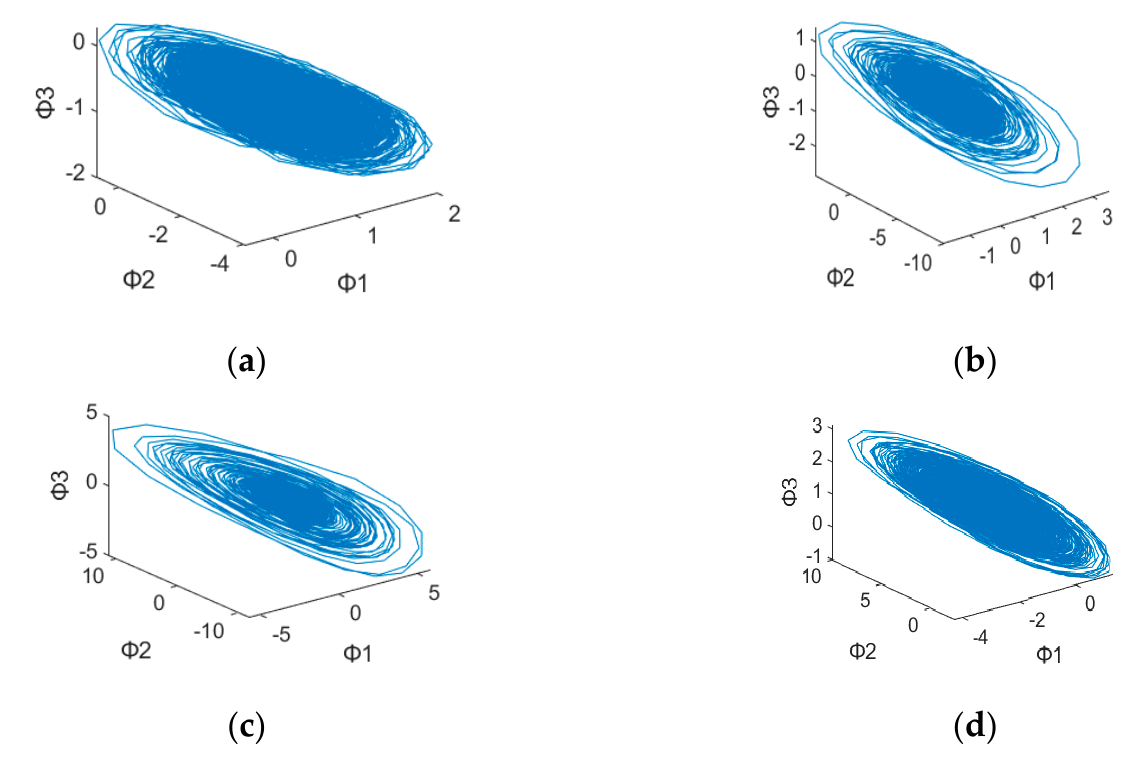
Figure 6. 3D dynamic error phase diagram of ball bearing under testing, with α = 0, HP = 0, and SPOF diameter = 0.014 in. ( a ) Normal state. ( b ) Ball fault. ( c ) Inner race fault. ( d ) Outer race fault.